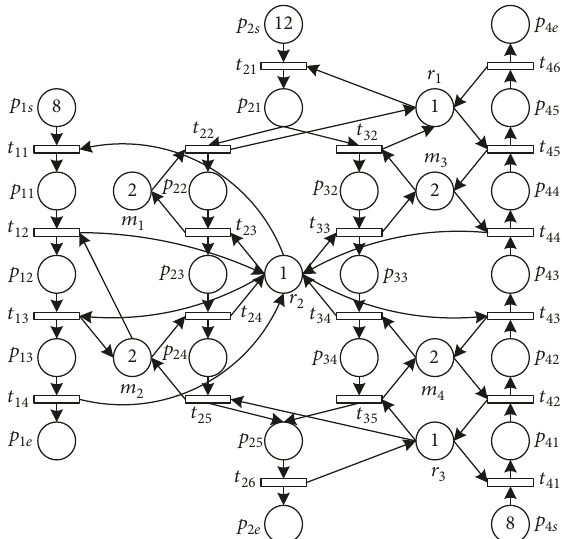
Figure 4: PNS model of the studied FMS (In01).